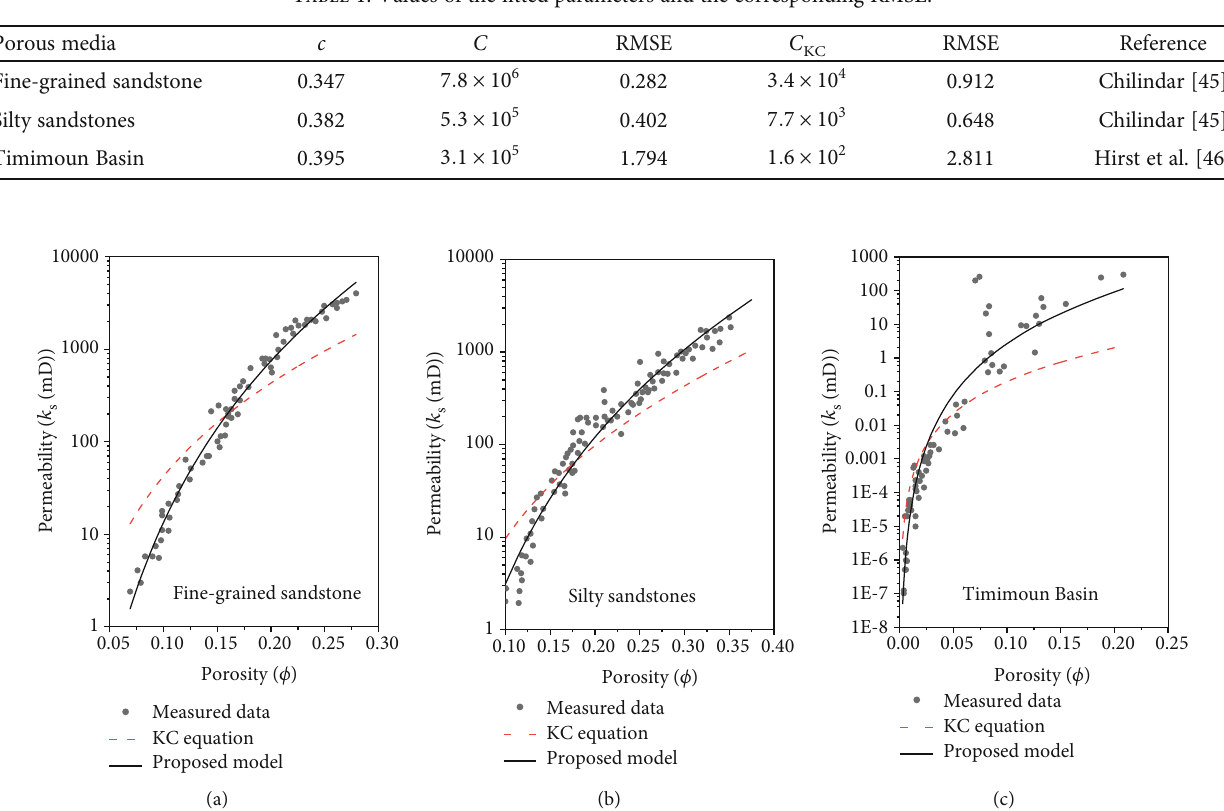
Table 1: Values of the fi tted parameters and the corresponding RMSE.